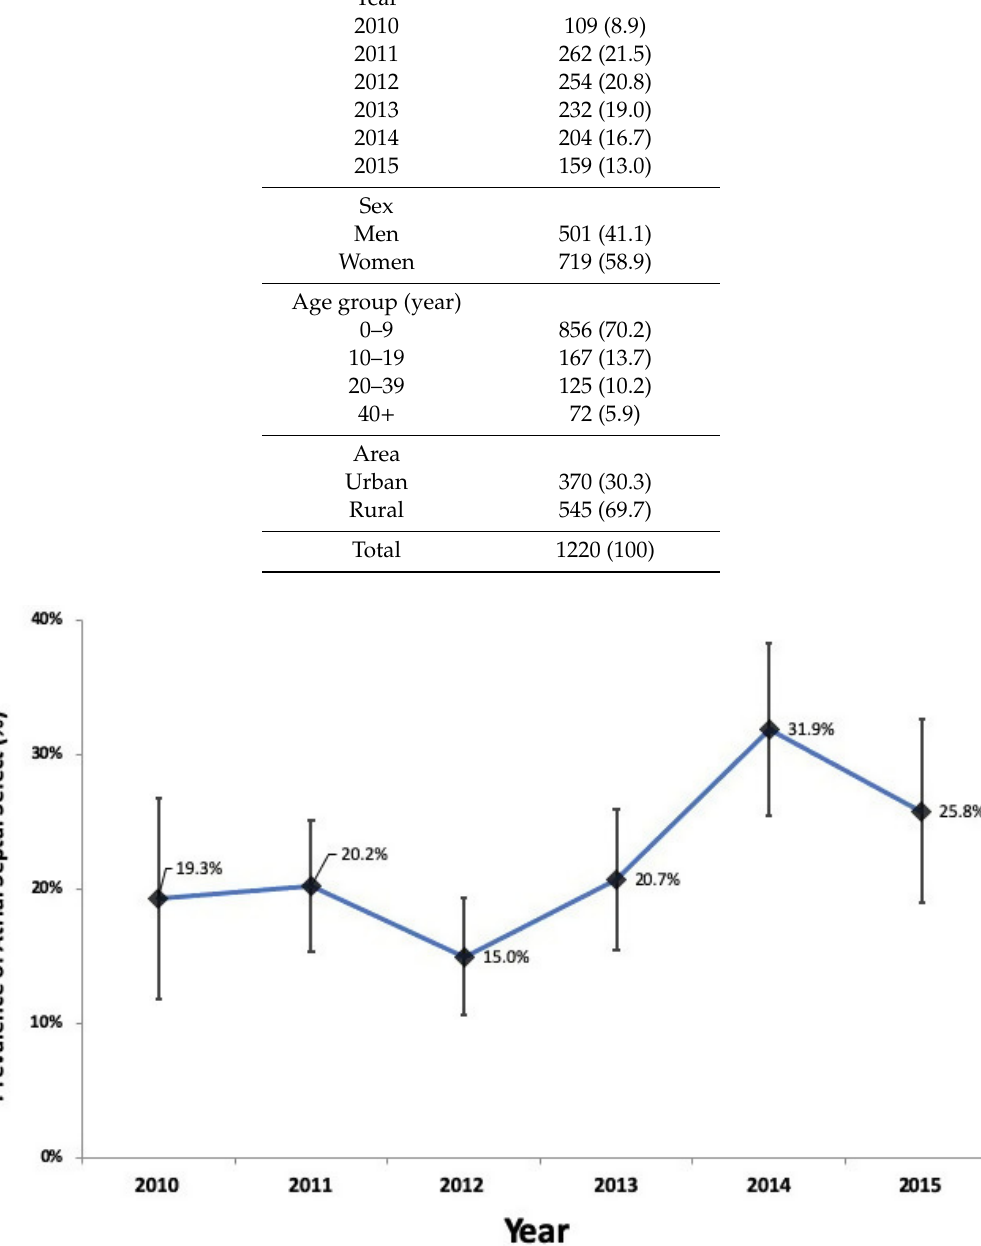
Figure 1. Trends in prevalence and 95% CI of atrial septal defect among congenital heart disease patients, 2010–2015. Table 1. Characteristics of congenital heart disease patients in the study, 2010–2015.